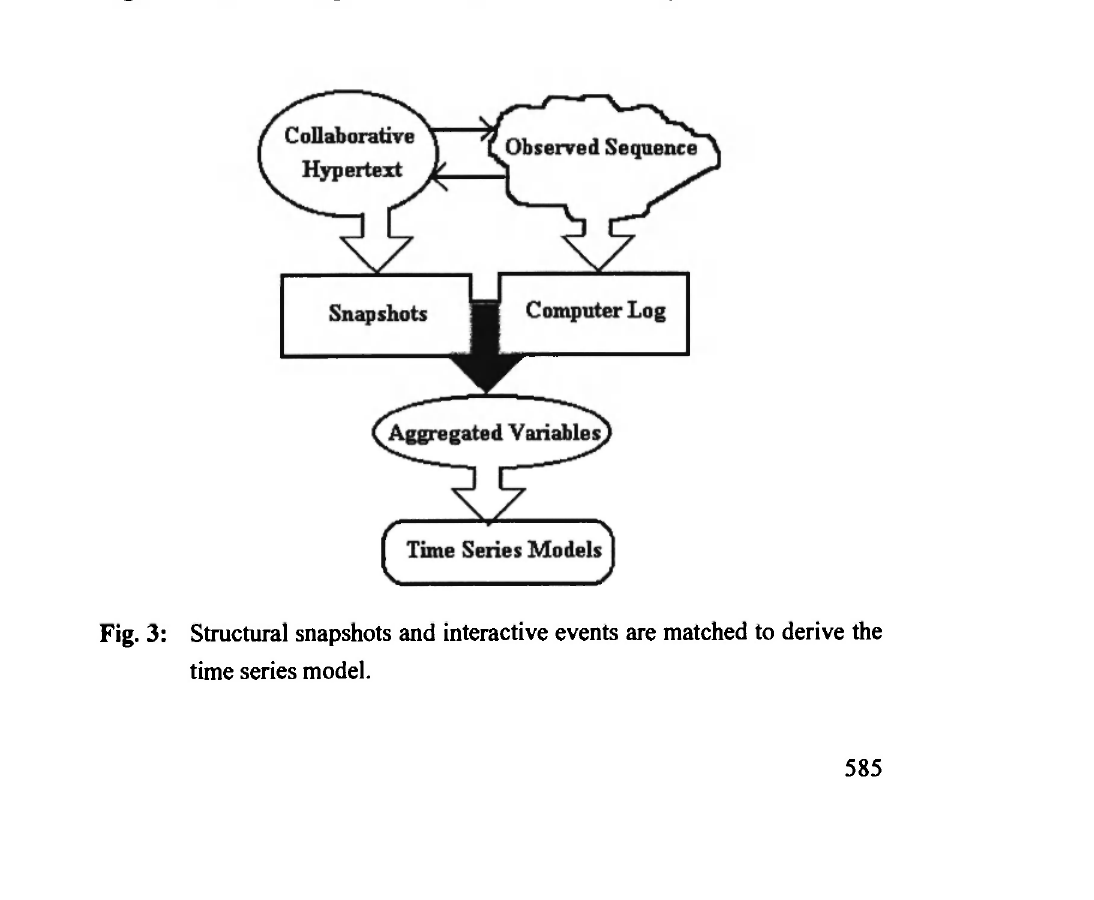
Fig. 2: A traversal algorithm and the resultant hierarchy of the traversal.